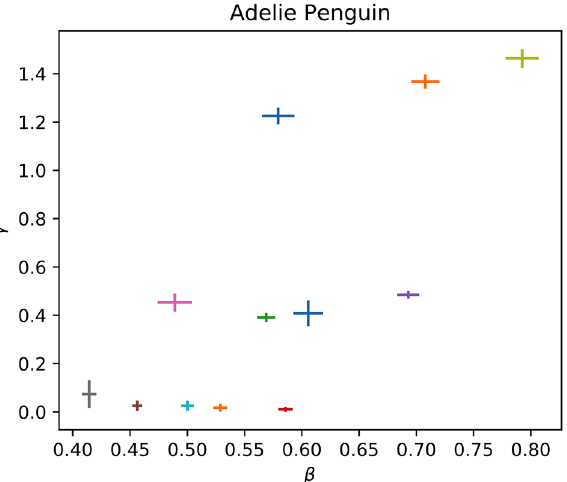
Figure 4. The inferred fractal parameters γ and β are shown for all recordings of the Adelie Penguin which were analyzed. Note that there seem to be three populations with distinct parameters, namely one in the bottom-left, one in the middle, and one in the